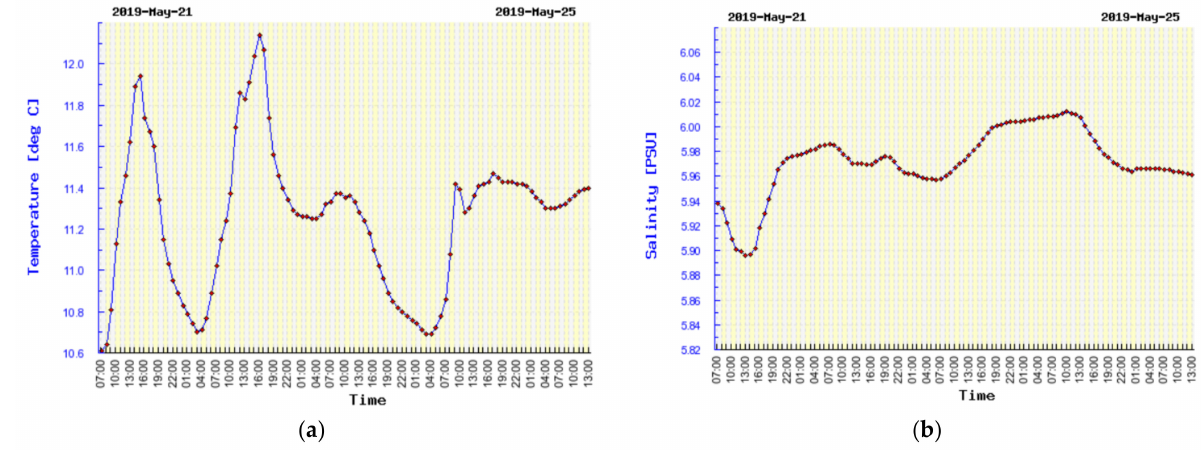
Figure 10. Temperature ( a ) and salinity ( b ) recorded in the station in Gdynia for measurements in the marina and public